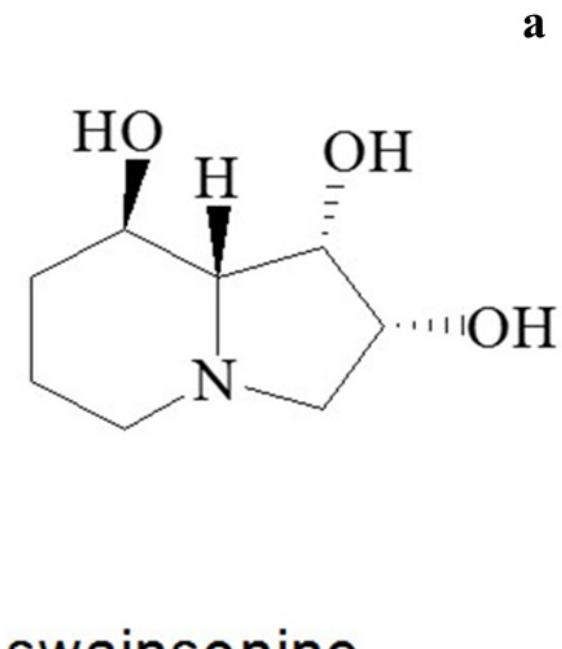
Figure 1a. Representative structure of indolizidine alkaloid.